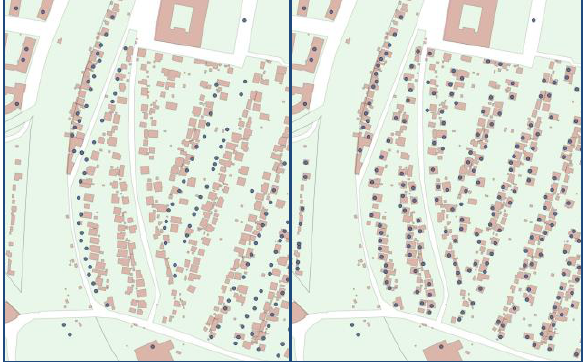
Figure 5. Example of addresses not automatically geocoded or falling outside the building geometries (left) and after editing